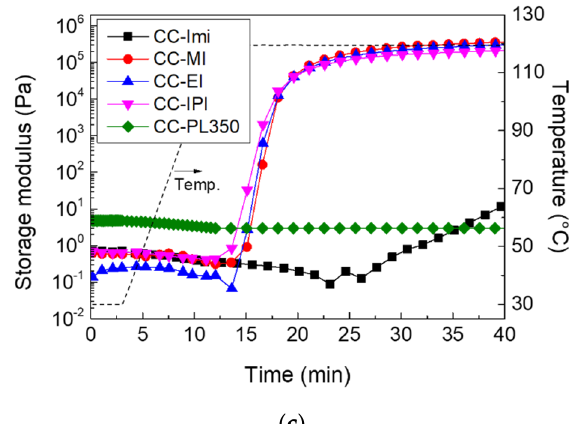
Figure 4. Real-time storage moduli of clearcoats with imidazole-BIs or BI-PL350 at ( a ) 100 °C, ( b ) 110 °C, and ( c ) 120 °C.